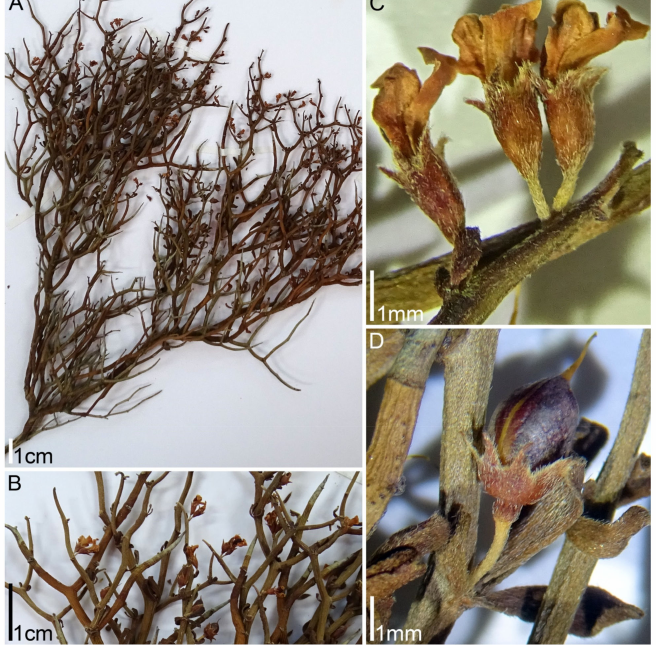
Figure 6. Morphology of Lotus dorycnium ssp. fulgurans . Herbarium specimen: Spain, phare de Formentor, Majorque, A. Sotiaux 1 (MA 748212): ( A ) habit; ( B ) fragments of thorny shoots; ( C ) flowers; ( D )